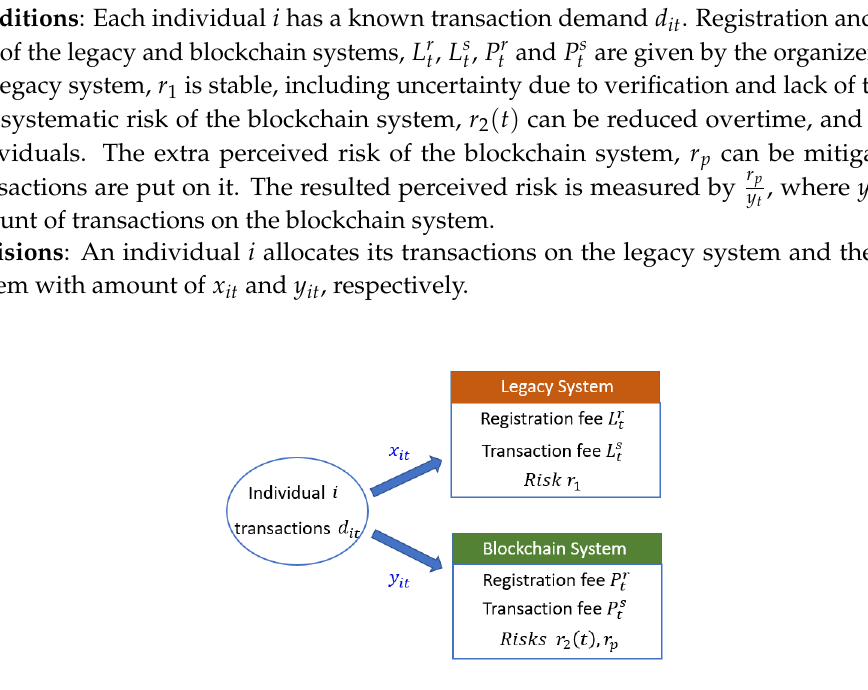
Figure 3. Individuals’ model. Table 2 list parameters and variables of individuals’ model. Table 2. Notations of variables and parameters of individuals’